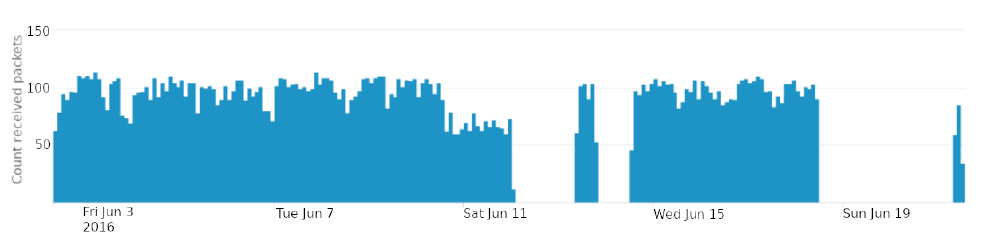
Figure 6. Number of packets received from the SCK node aggregated every two hours.